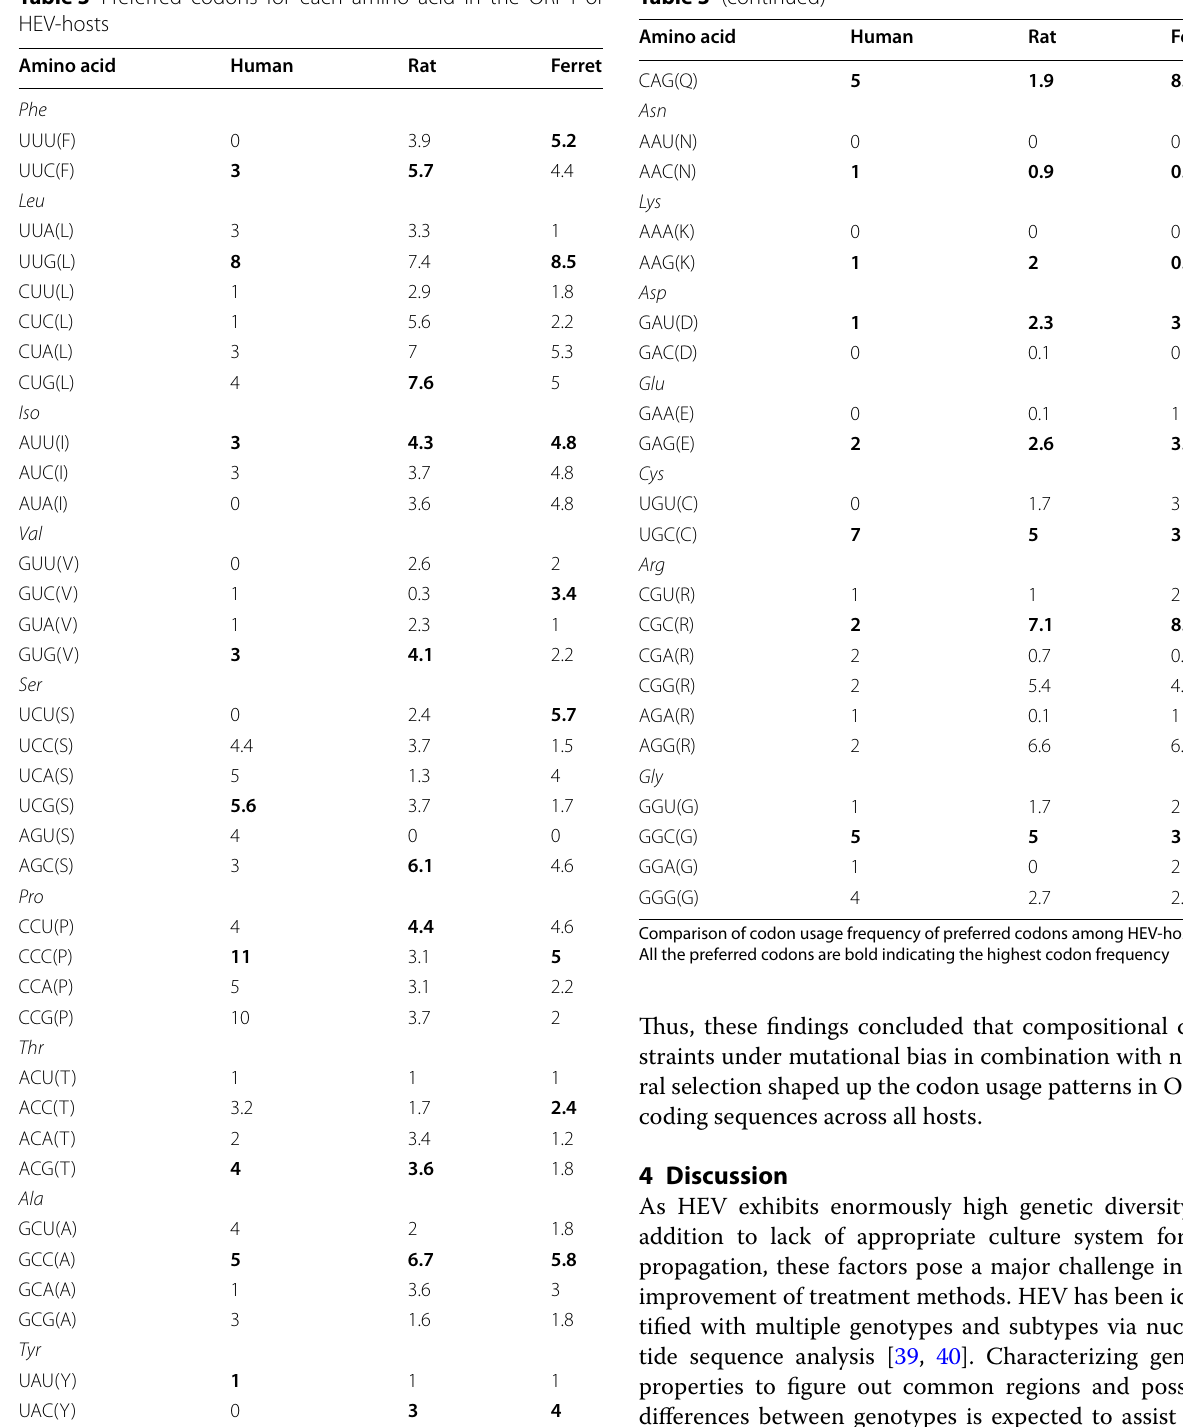
Table 3 Preferred codons for each amino acid in the ORF4